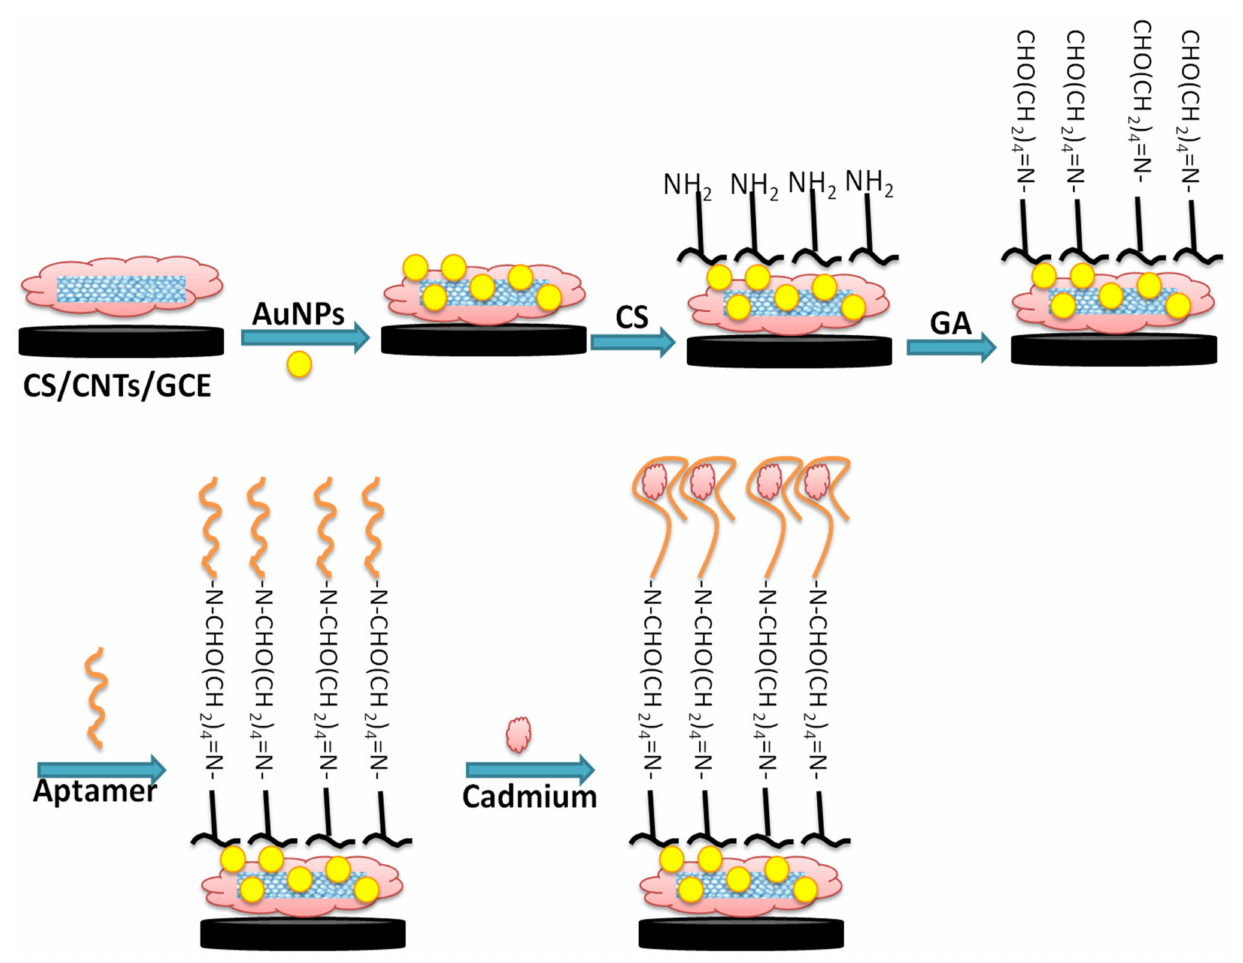
Figure 1. Schematic illustration of GCE chemical surface modification with CNTs-AuNPs/CS nanocomposite for aptamer immobilization and application in cadmium